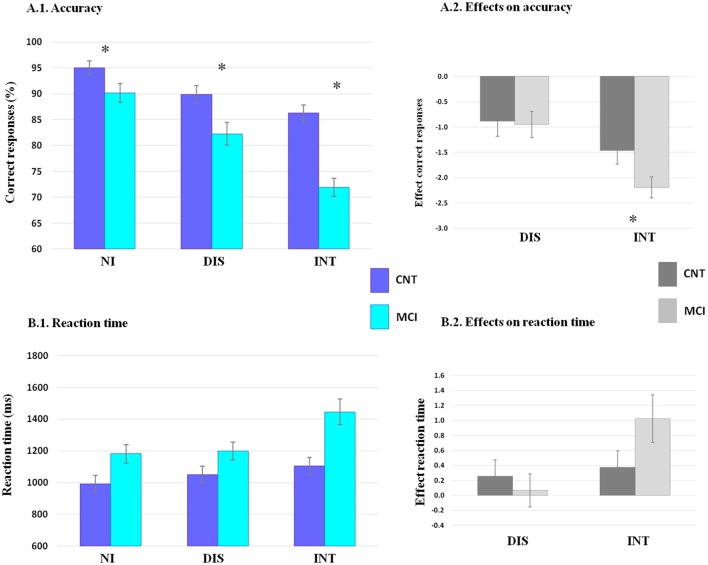
Results for accuracy and reaction time (RT) are shown. The percentage of correct responses (A.1) and RT in milliseconds (B.1) are shown for each condition (non-interference, NI, distraction, DIS, and interruption, INT) in each group (controls, CNT, dark blue, and MCIs in light blue). The effects of interference on accuracy (A.2) and RTs (B.2) are shown for distraction (DIS) and for interruption (INT) in each group (controls, CNT, in dark gray and MCIs in light gray). Error bars denote standard error of the mean. Statistical analysis of the accuracy revealed main effect of diagnosis and condition (p < 0.001), and a condition × group interaction (p < 0.005). The effect of interruption on accuracy was significantly greater in patients than with controls (p < 0.05). Reaction times showed main effect of diagnosis and condition (p < 0.001). *indicates significant difference between groups (p < 0.05).